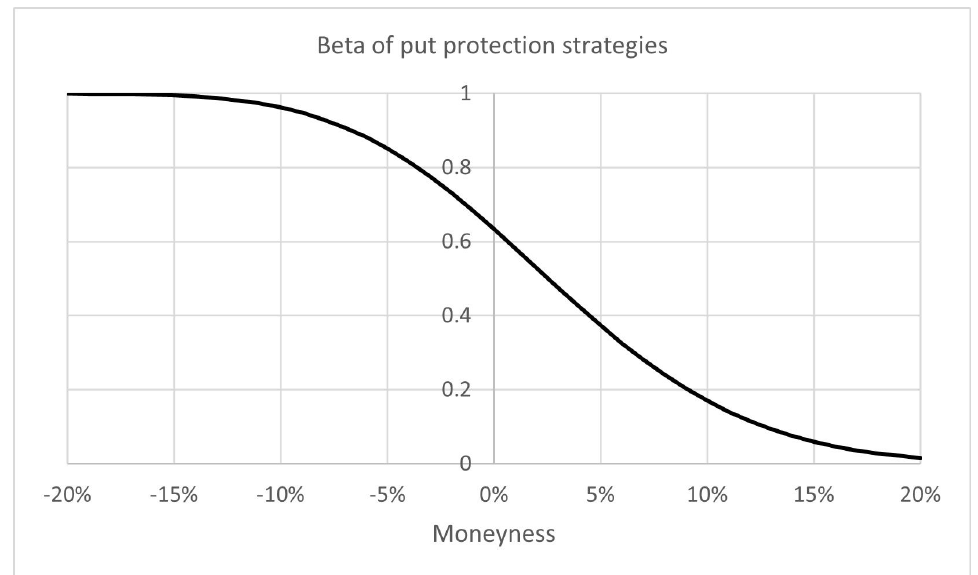
Figure 13. The price sensitivity (beta) of an underlying asset with an overlaid put protection strategy for a range of strike prices in relation to price change of the underlying